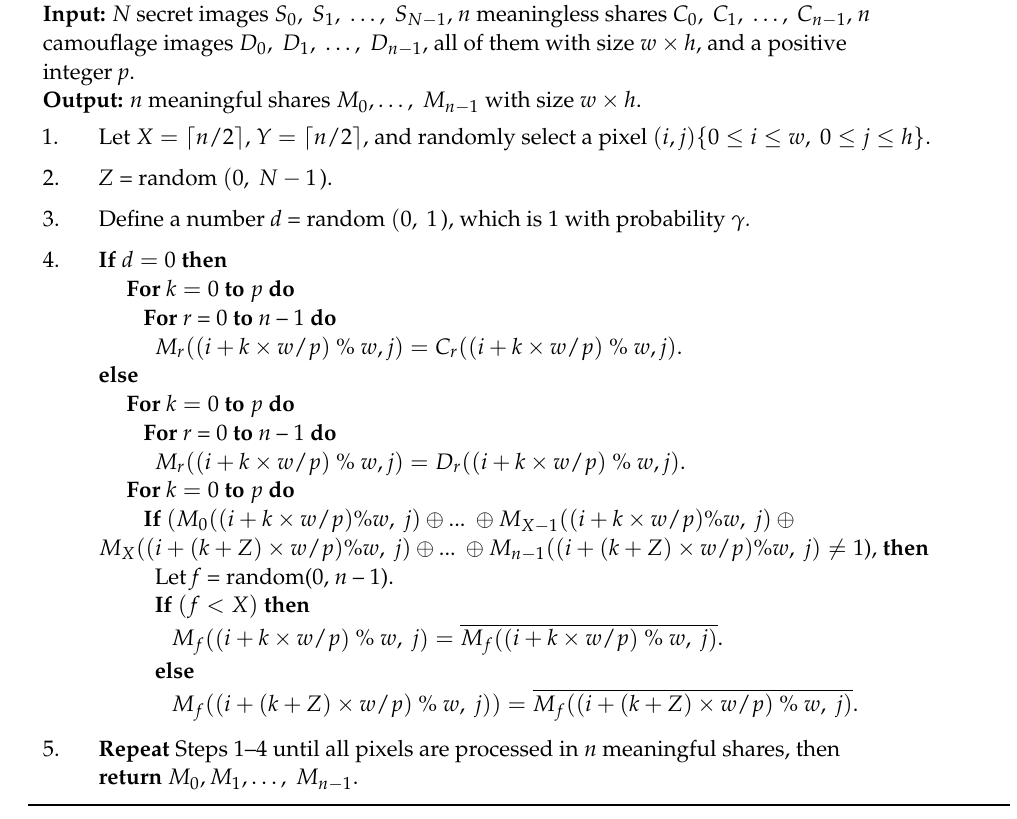
Algorithm 4. [Method 2 ] Enhanced encryption